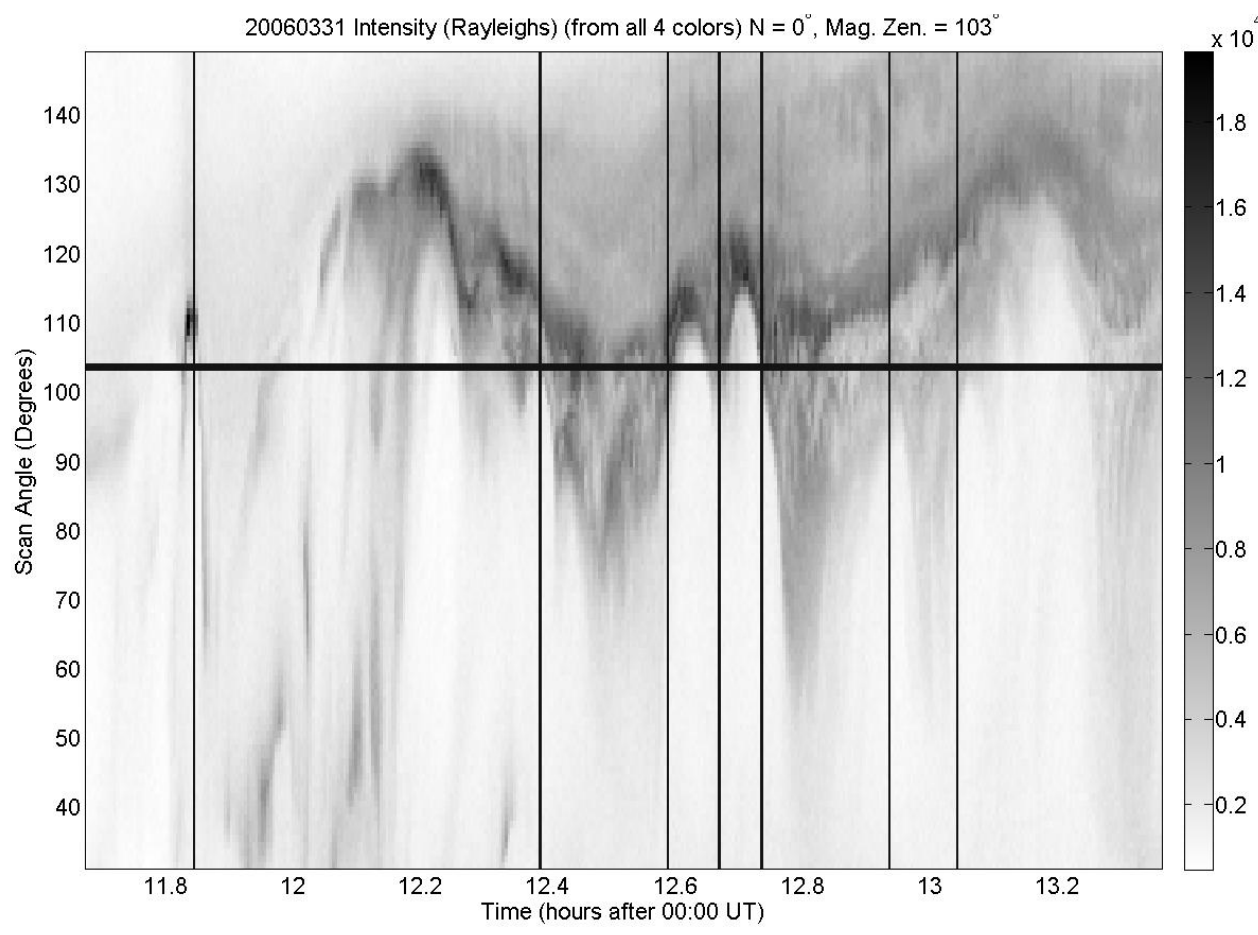
Fig. 3. The MSP data, summed over three wavelengths (557.7nm, 630.0nm, 427.8nm) and plotted as an image of intensity versus elevation angle versus time. North is at an elevation of 0 ◦ , and the magnetic zenith is at 103 ◦ , indicated by the horizontal line. The seven vertical lines indicate the times of the seven NEIALs from Fig. 2. NEIALs are seen when the poleward edge of the auroral activity intersects the zenith-looking radar